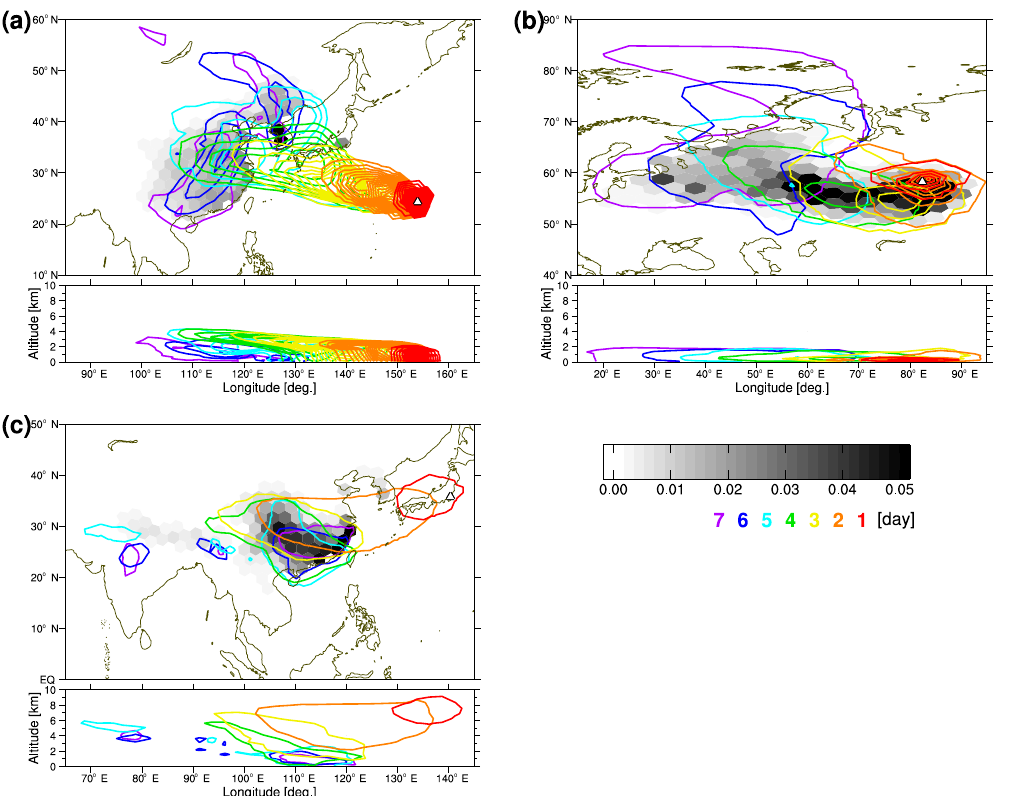
Figure 7. The normalized flux contributions (gray shades) and the adjoint trajectory volumes (color contours) are shown for the high CO 2 concentration events observed at Minamitorishima on 24 January (a) , at Karasevoe on 27 December (b) , and at 8km over Narita on 12 Jan- uary 2010 (c) , which are denoted by the cyan arrows in Fig. 4. See the text for the definitions of the flux contribution and the adjoint trajectory volume. The upper and lower panels present the horizontal and vertical structures of the adjoint trajectory volume, whose maximum values are projected onto the horizontal and vertical planes, respectively. The adjoint trajectory volumes are drawn with contours starting from a minimum value 0.02 at an interval of 0.6. The color of the contour represents how many days prior to the observation time to which the adjoint trajectory volume is